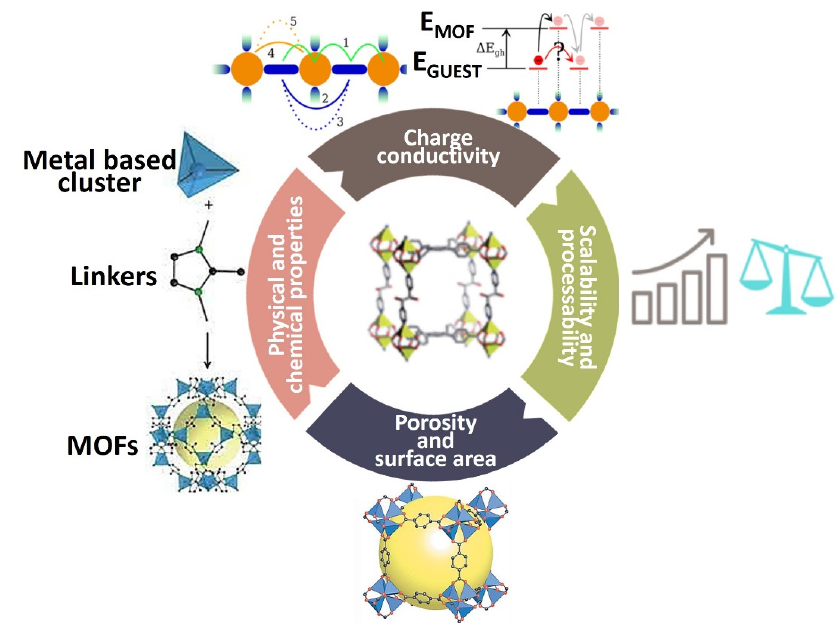
Figure 1. Tunable properties of MOF during a synthesis.